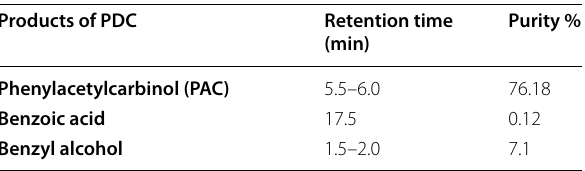
Table 4 Determination of PAC, benzoic acid, and benzyl alcohol through HPLC Products of PDC